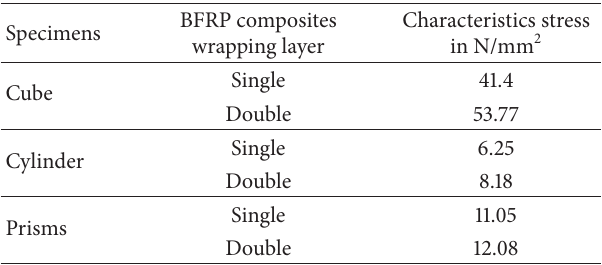
Table 7: BFRP wrapped concrete specimens characteristic stress.